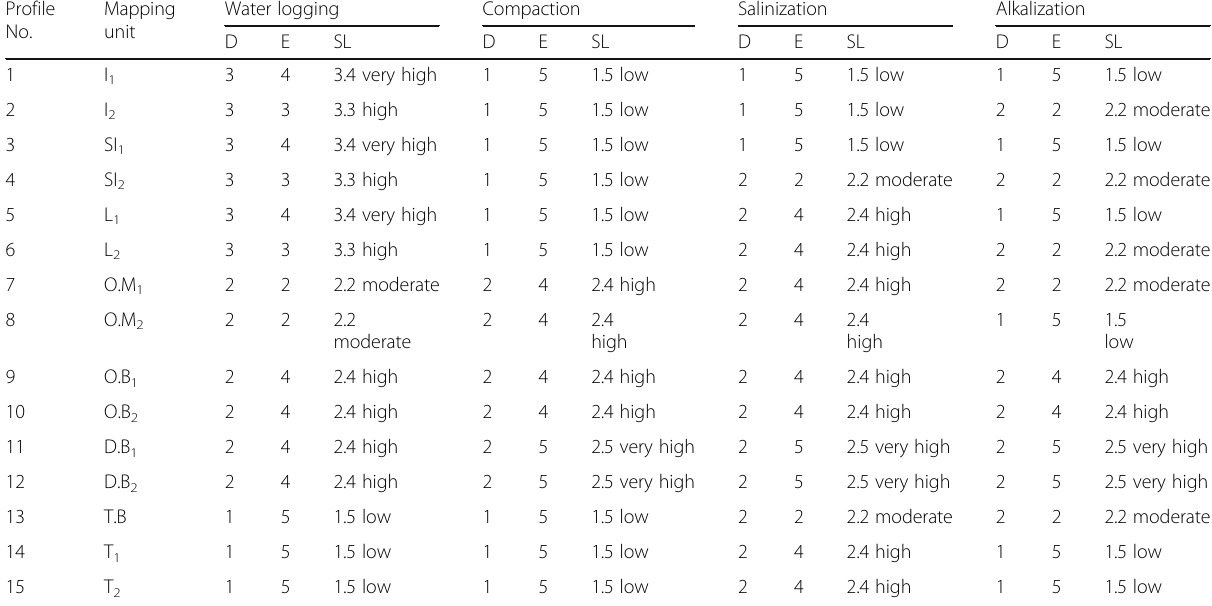
Table 13 Land degradation severity level in the study area Profile No.